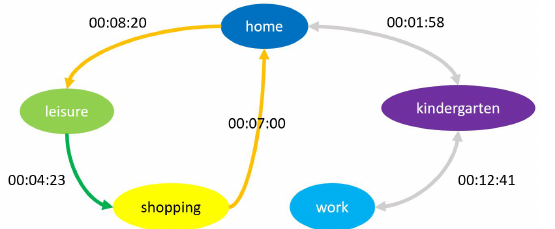
Figure 24. Trips’ predicted travel time: the green arrow is a walking trip, the gray arrows are car trips, and the orange arrow is a public transportation trip.